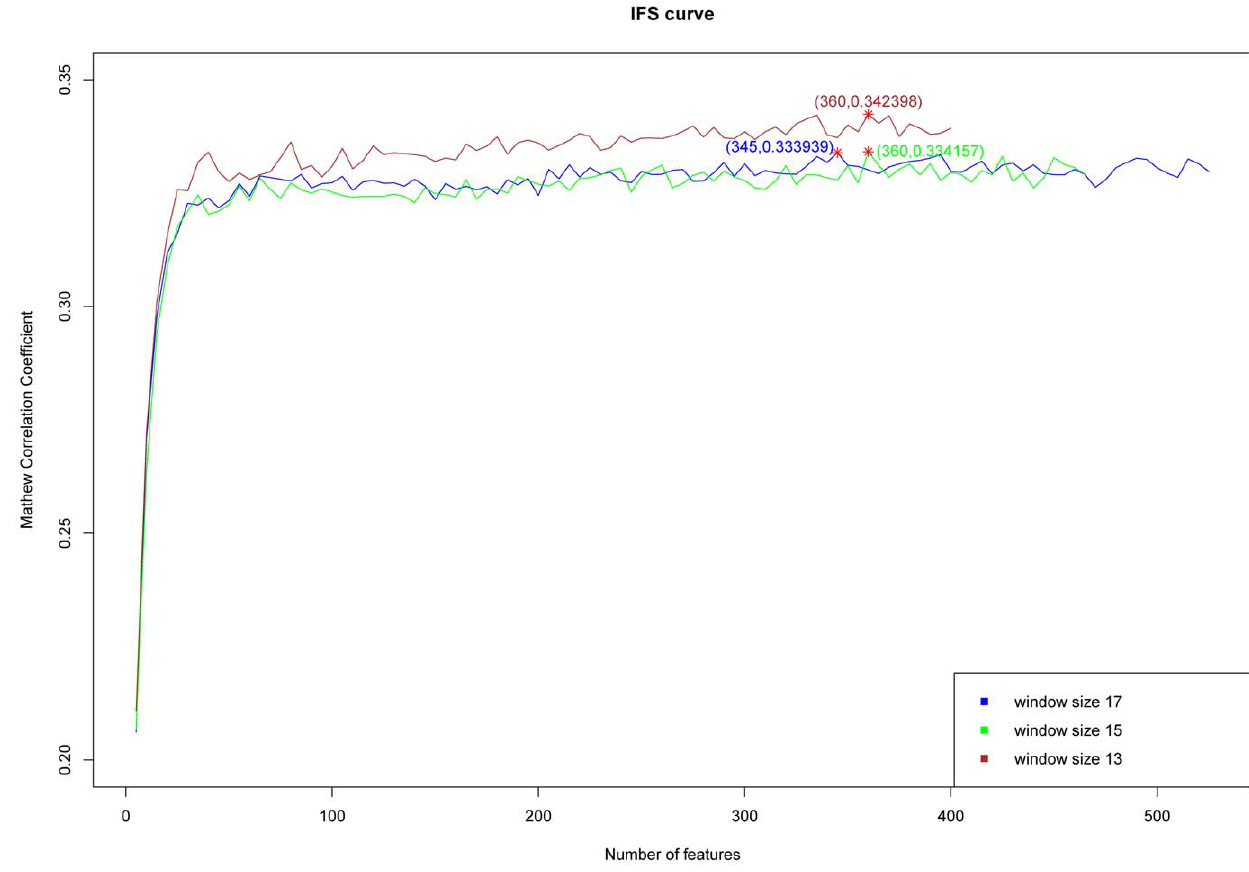
Figure 1. A plot to show the change of the MCC values versus the feature numbers with different window sizes. The IFS curves were drawn based on the data in Online Supporting Information S3. The MCC value reached the peak when the number of feature=360 and the window size=13. The 360 features thus obtained were used to form the optimal feature set for the protein domain predictor. Purple line is for the case of size-17 window, green for size-15 window, and brown for size-17 window. See the text for further explanation.